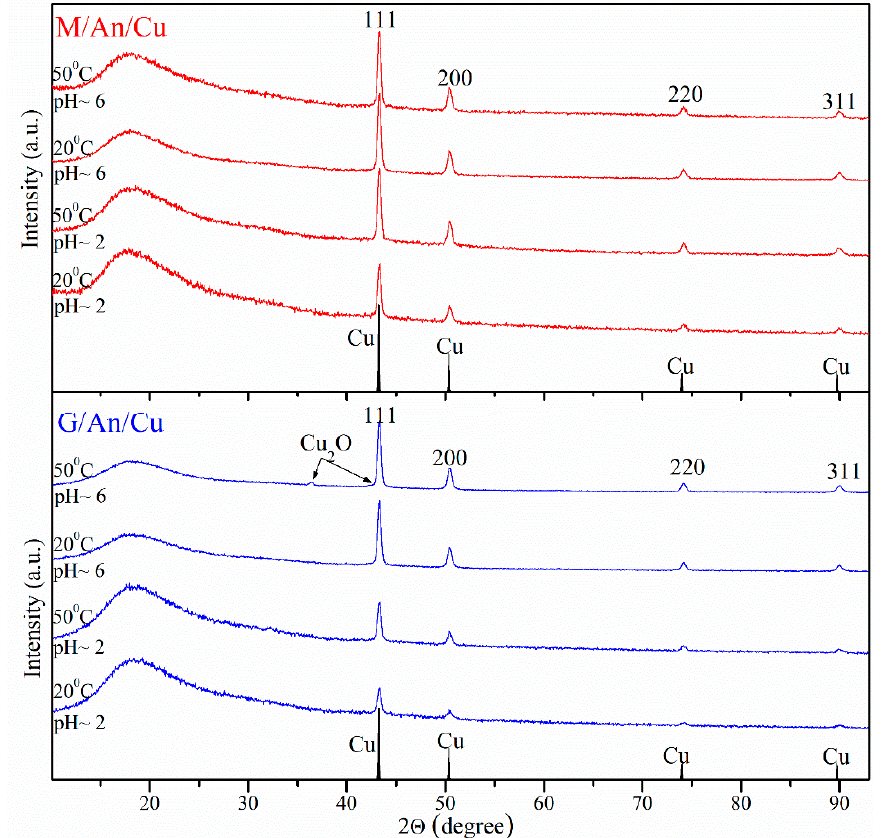
Figure 1. XRD patterns of reduction reaction products M/An/Cu and G/An/Cu.